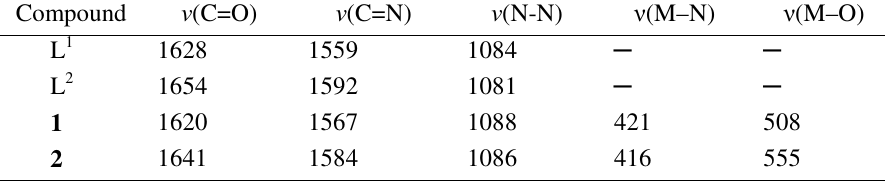
Table 2. IR spectral Bands of ligands and its metal